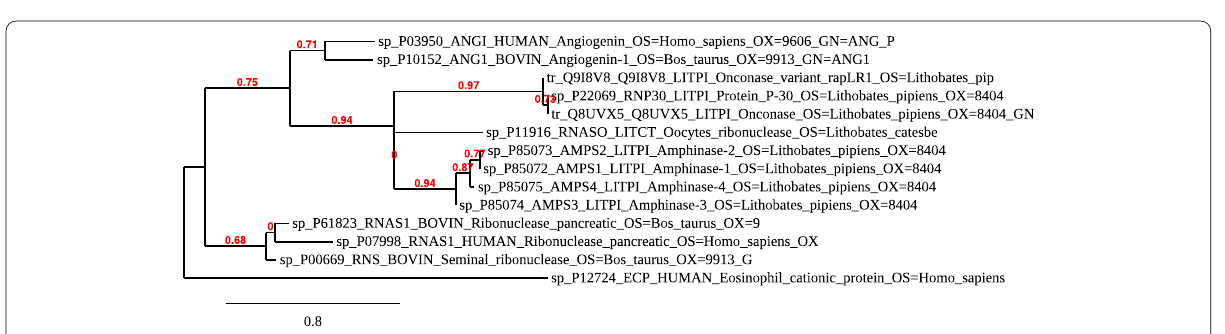
Fig. 2 Phylogenetic tree of 14 protein coding sequences of eukaryotic ribonucleases. A scale bar (0.8) indicates the genetic distance of protein sequences of eukaryotic